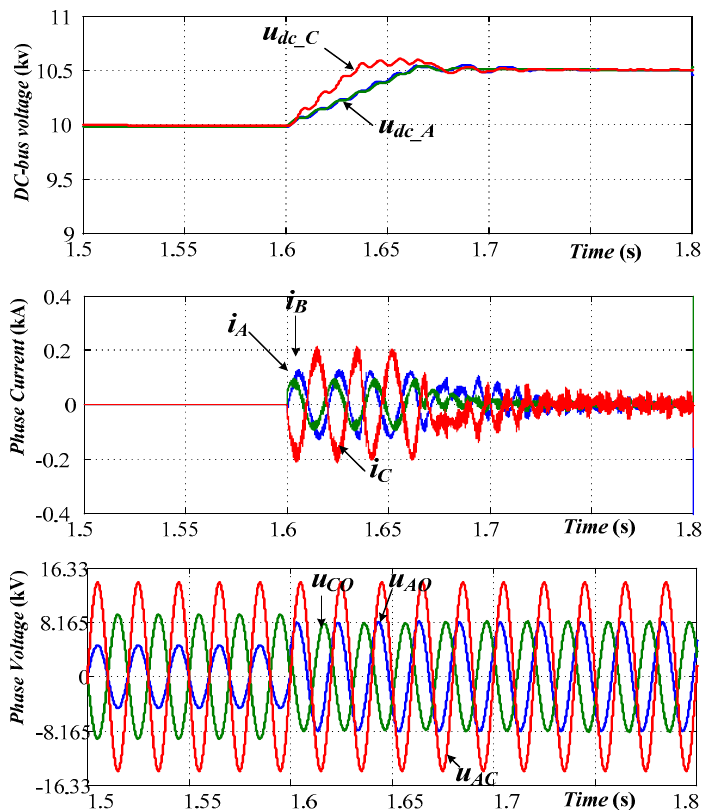
Electronics 2019 , 8 , x; doi: FOR PEER REVIEW Figure 8. Simulation results when the DC-bus voltage reference is step. Figure 8. Simulation results when the DC-bus voltage reference is step.